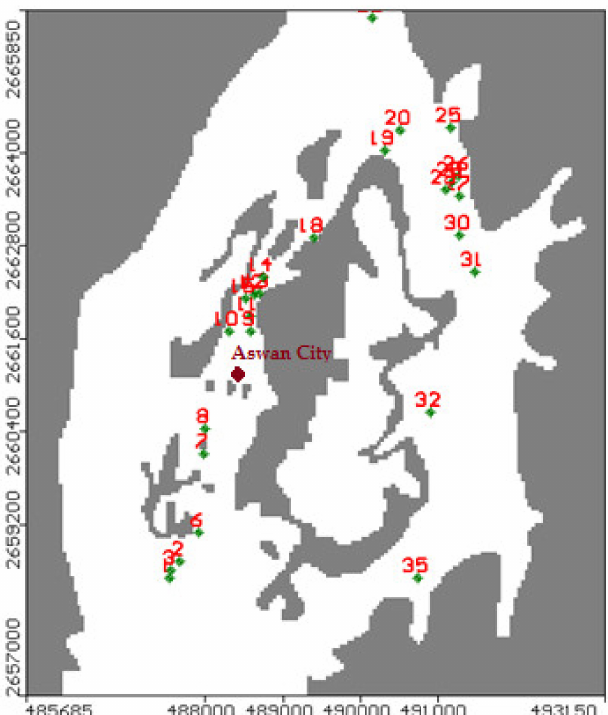
Figure 8. Distribution of observation wells in study